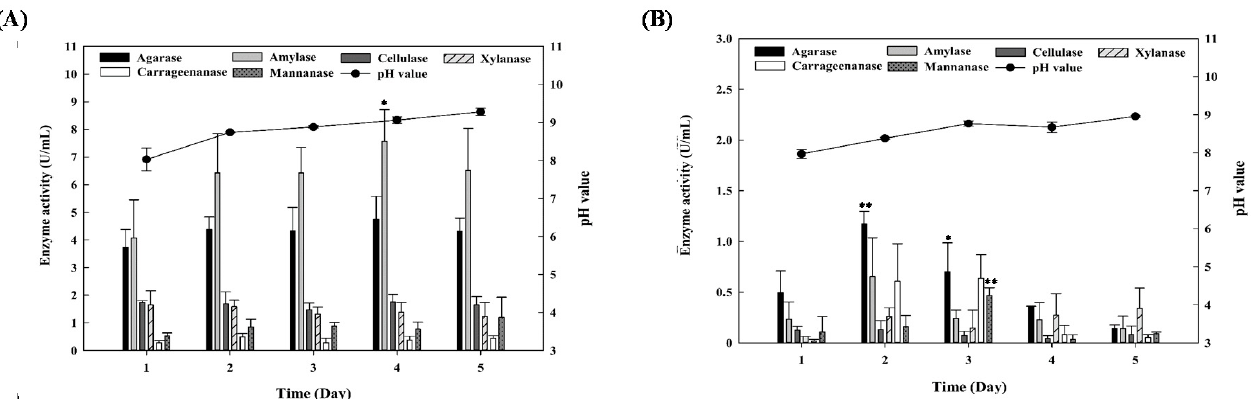
Figure 1. The pH value and enzyme activity of crude enzymes solution during incubation period of P. vesicularis MA 103 ( A ) and A. salmonicida MAEF108 ( B ) induced with MMB- Porphyra media. Each value is mean ± standard deviation ( n = 3). Comparison of activity of the same enzyme at different time, * and ** indicate significantly different at p < 0.05 and p < 0.01, respectively.